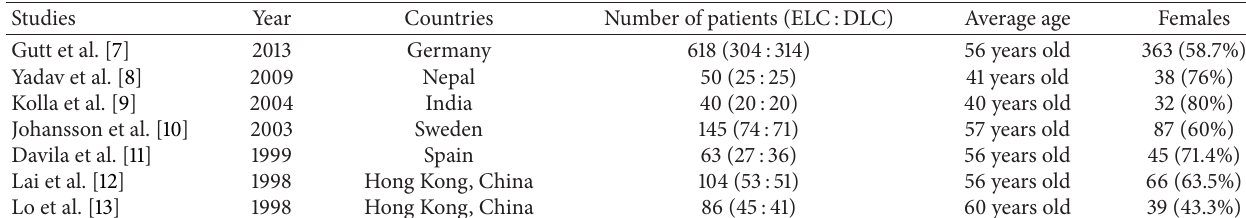
Table 1: Baselines of included